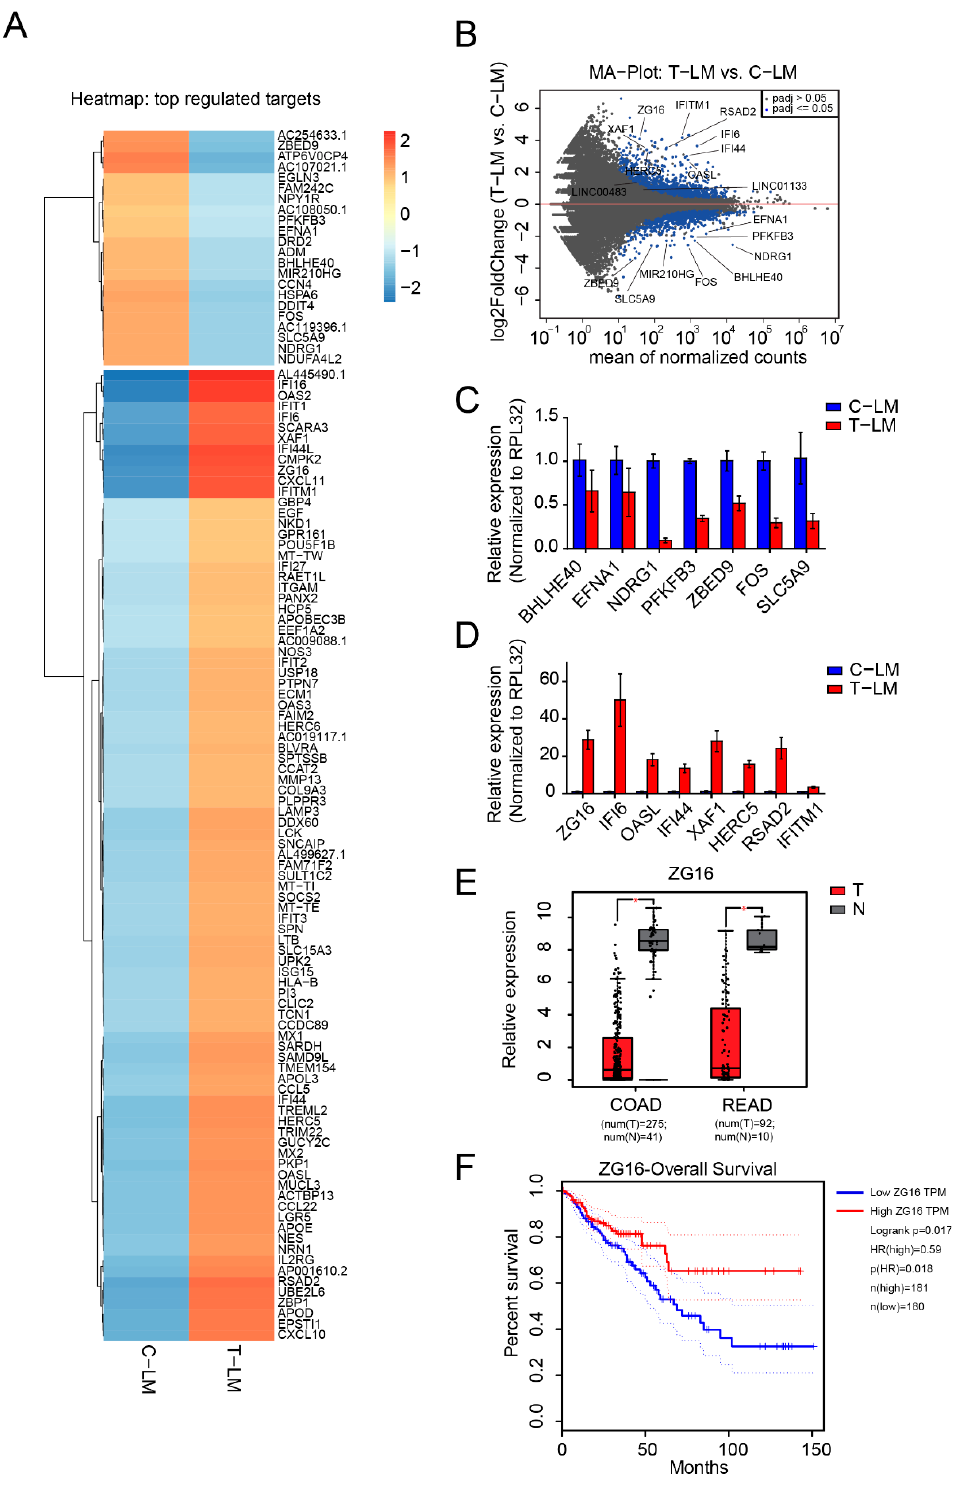
Figure 2. Identification of mRNAs regulated during LDM topotecan chemotherapy . (A ) Heatmap of differentially expressed mRNAs in liver metastases from treated mice (T-LM) versus liver metastases from control mice (C-LM). ( B ) MA plot of mRNA expression in liver metastases from treated mice (T-LM) versus liver metastases from control mice (C-LM). ( C , D ) Validation of downregulated and upregulated mRNA from treated liver metastases compared to control liver metastases by qPCR. ( E ) Boxplot showing the significant downregulation of ZG16 in colon adenocarcinoma (COAD) and rectum adenocarcinoma (READ) obtained from TCGA data, T: Tumors, N: Normal tissues. ( F ) Survival plot presents patient survival with expression of ZG16 . The data from ( E , F ) was obtained from Gene Expression Profiling Interactive Analysis GEPIA web server